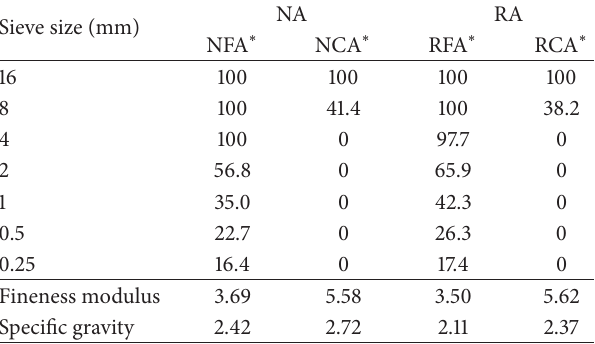
Table 2: Physical properties of NA and